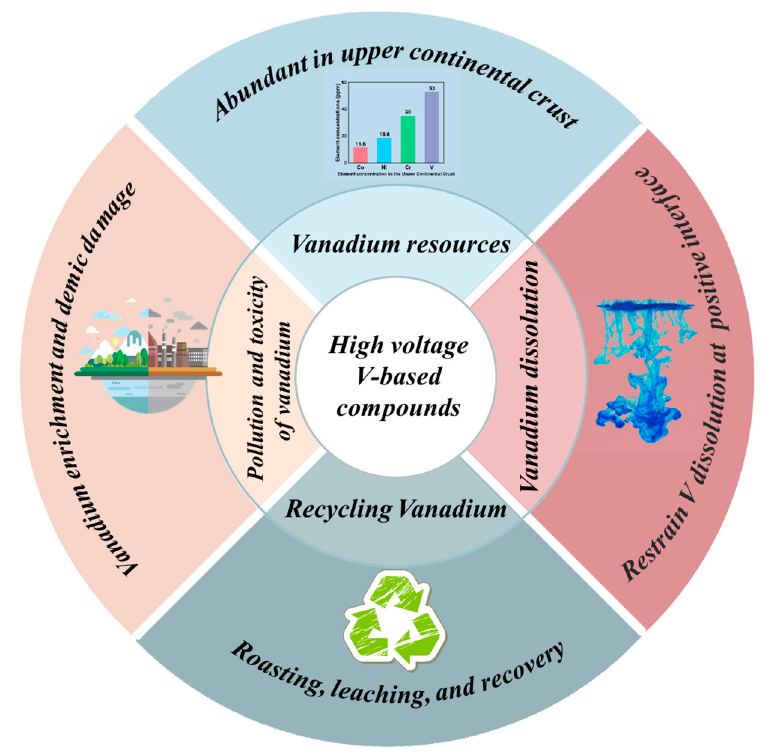
Figure 9. Perspective on the application of high-voltage V-based compounds [117].